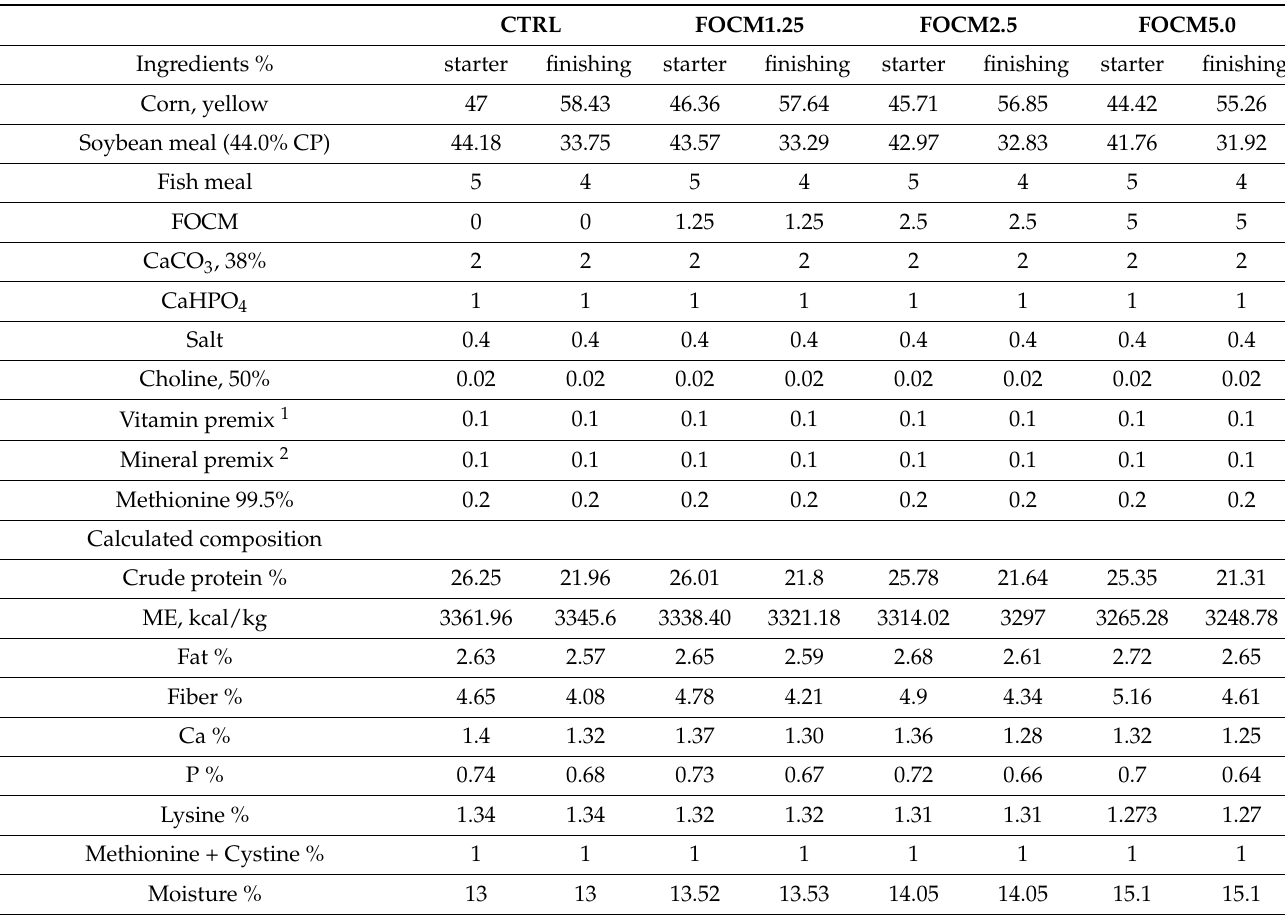
Table 1. Nutrient composition of experiment diets (starter and finisher